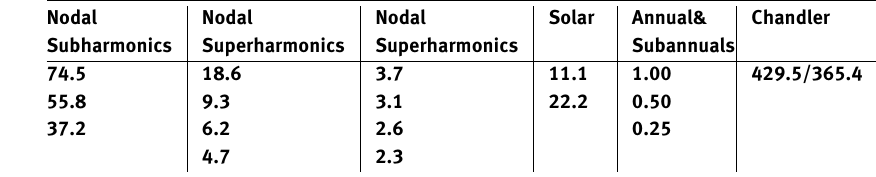
Table 1. Compounded Luni-Solar periods (yr.).